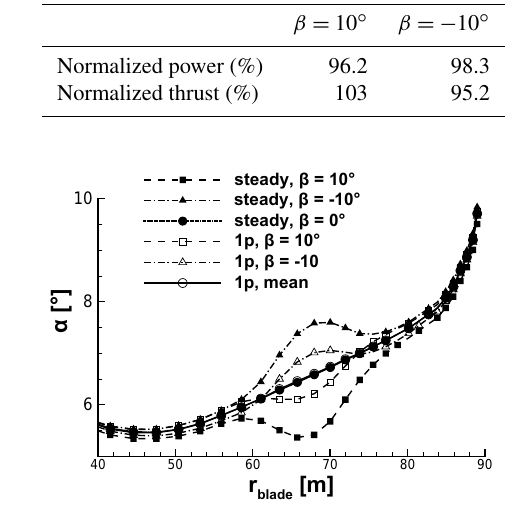
Table 3. Integral loads for steady deflection normalized with value for β = 0 ◦ .